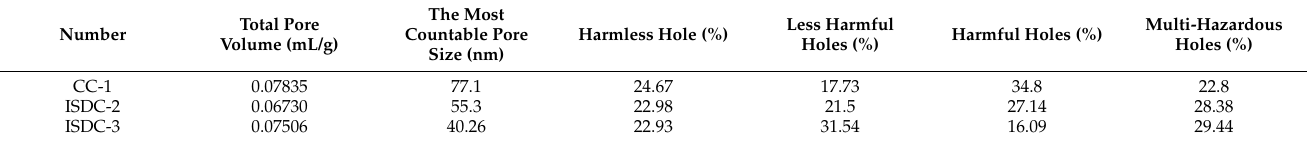
Figure 7. ( a ) Cumulative pore volume, ( b ) pore distribution, and ( c ) cumulative pore ratio of concrete at each ISD dose. Table 6. Results of mercury intrusion porosimetry.